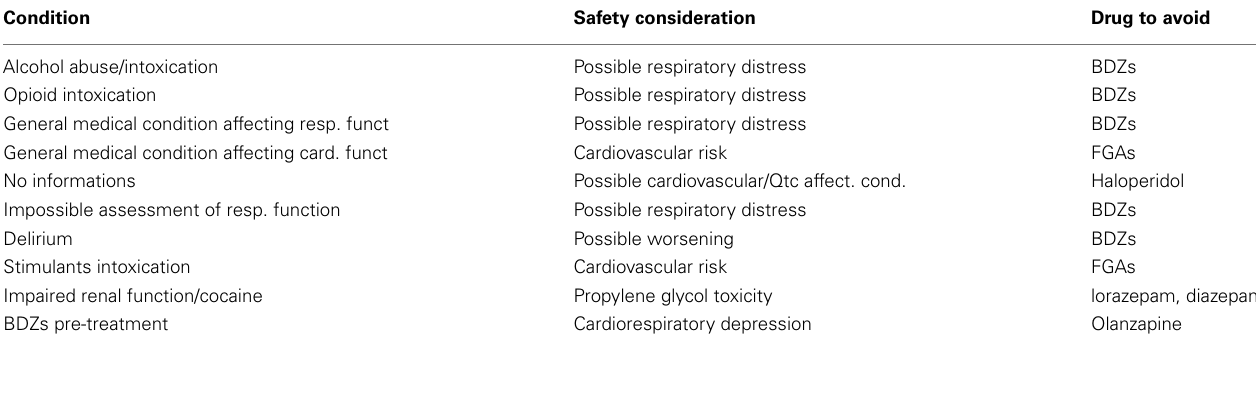
Table 3 | Conditions and safety considerations that should preclude specific drug choice during IM treatment of agitation in emergency settings due to fatality